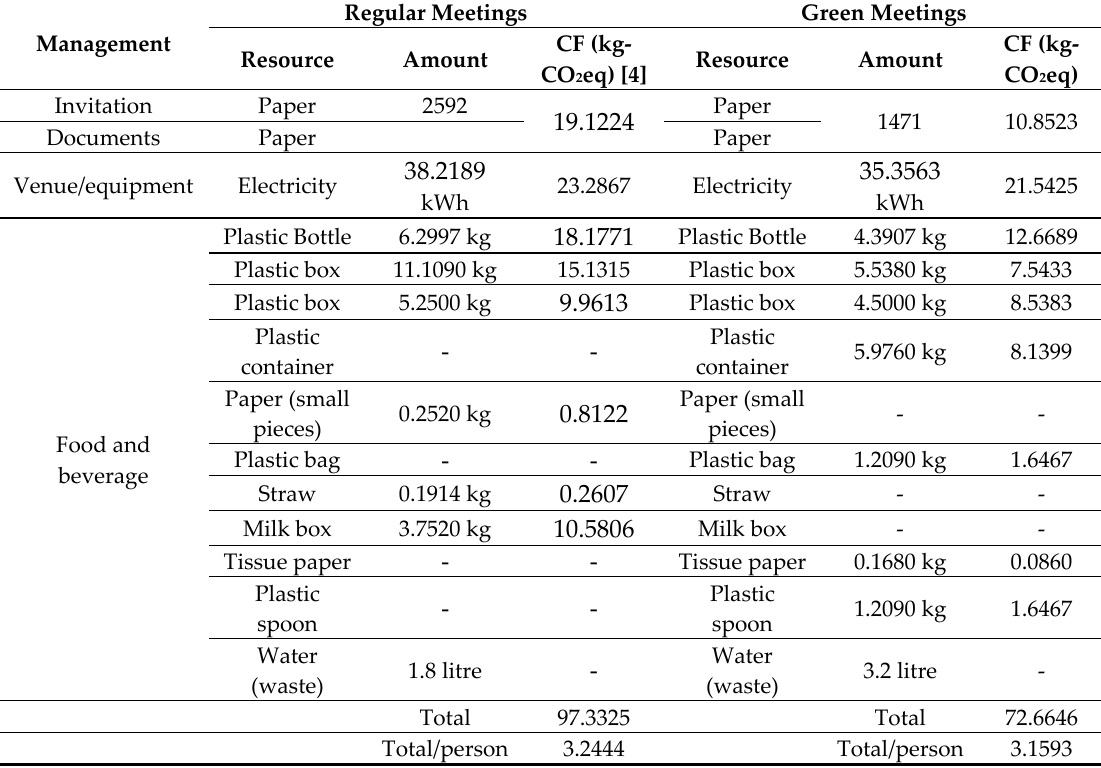
Table 2. Comparison of regular and green meeting’s carbon footprint for room